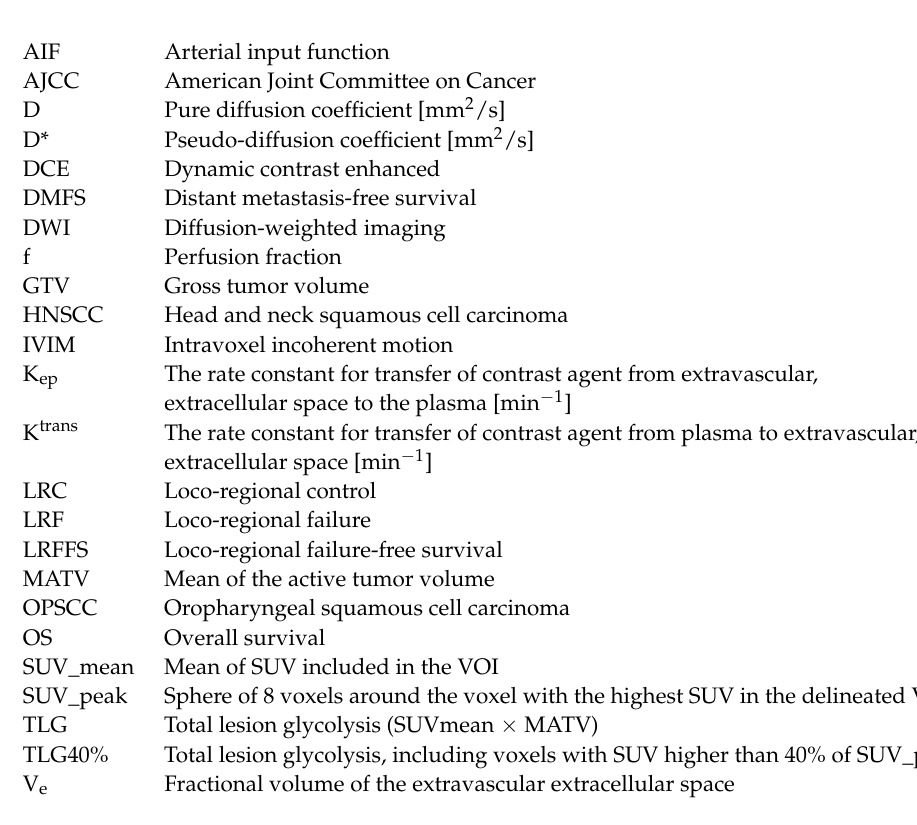
DMFS and OS, Figure S3: Locoregional recurrence-free survival curves per risk group, Figure S4: Distant metastasis-free survival curves per risk group, Figure S5: Overall survival curves per risk